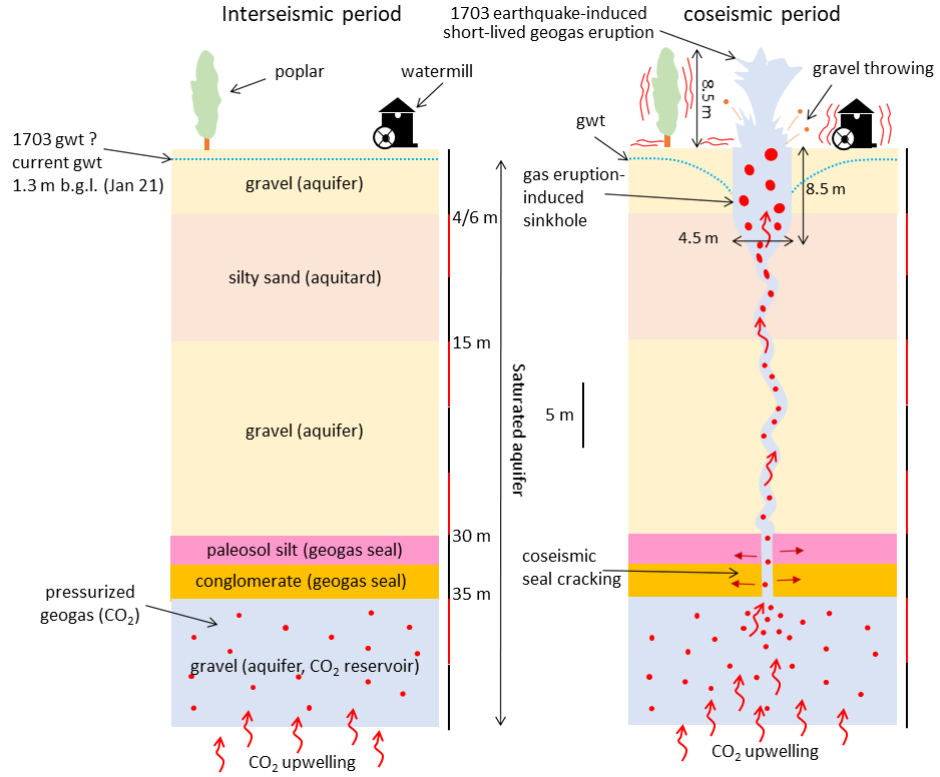
Figure 24. Unscaled sketch of the earthquake-induced gas eruption hypothesis at the MDF site.